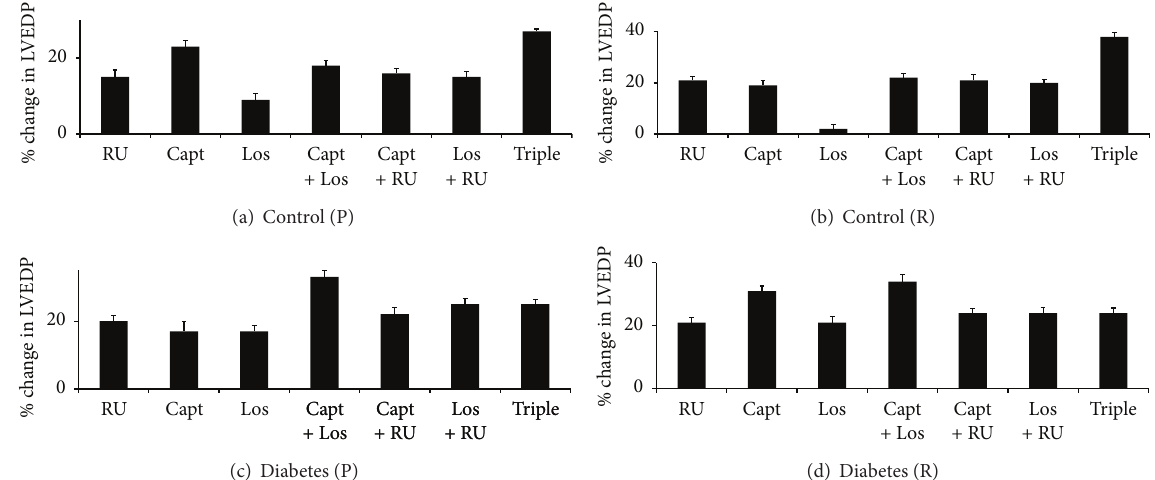
Figure 6: A comparison of the % change in left ventricular end-diastolic pressure (LVEDP) in control and diabetic hearts following acute treatmentwithvariousdrugregimens.Drugsweregiventocontrolheartsduringperfusion(a)orreperfusion(b)andtodiabeticheartsduring perfusion (c) or reperfusion (d). The percent change in parameter is calculated relative to the % recovery seen in the respective nondiabetic or diabetic controls. RU: RU28318; Capt: Captopril; Los: Losartan; Triple: RU28318 + Captopril +